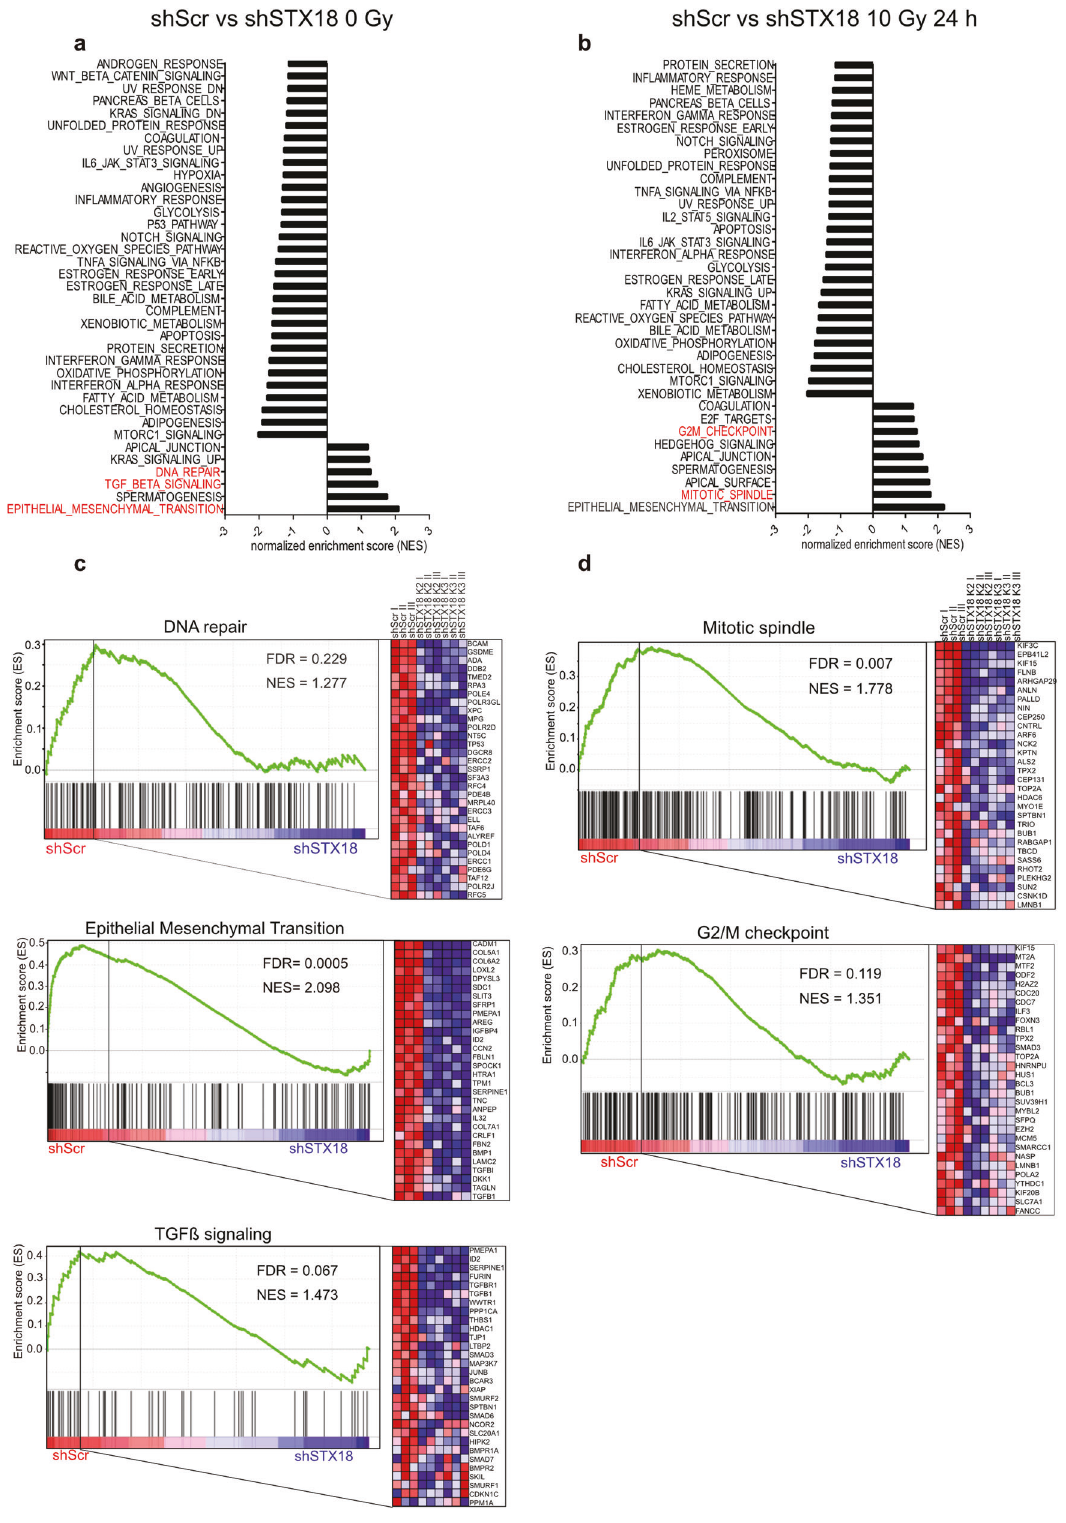
Fig. 3 RNA pro fi ling of A549 cells identi fi es differentially expressed gene sets after STX18 knockdown and irradiation. Differentially represented gene sets in shScr vs shSTX18 at basal level ( a ) and 24 h after irradiation with 10 Gy ( b ). Only the gene sets with an FDR < 0.25 are represented. For representation of A549-shSTX18 cells, counts from A549-shSTX18 K2 and K3 were pooled. c Enrichment plots of the gene sets “ DNA repair ” , “ epithelial mesenchymal transition ” and “ TGF β signaling ” enriched in A549-shScr vs A549-shSTX18 K2 and K3. Biological replicates are indicated with I, II, and III. The 30 most enriched genes for each gene sets are represented. d Enrichment plots of the gene sets “ mitotic spindle ” and “ G2/M checkpoint ” enriched in A549-shScr vs A549-shSTX18 K2 and K3 after irradiation. Biological replicates are indicated with I, II, and III. The 30 most enriched genes for each gene sets are represented. n = 3.